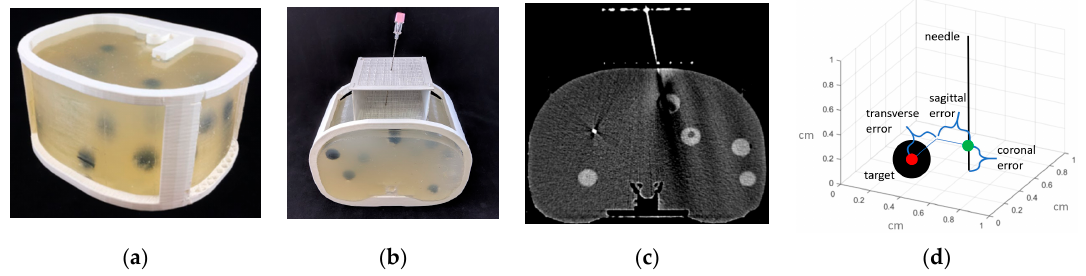
Figure 3. ( a ) 3D printed abdominal phantom for quantification of the lesion-targeting error. ( b ) Needle being inserted into the phantom using the device. ( c ) CT image showing needle insertion. ( d ) Targeting errors were measured in transverse, sagittal and coronal directions of the needle relative to the target lesion.